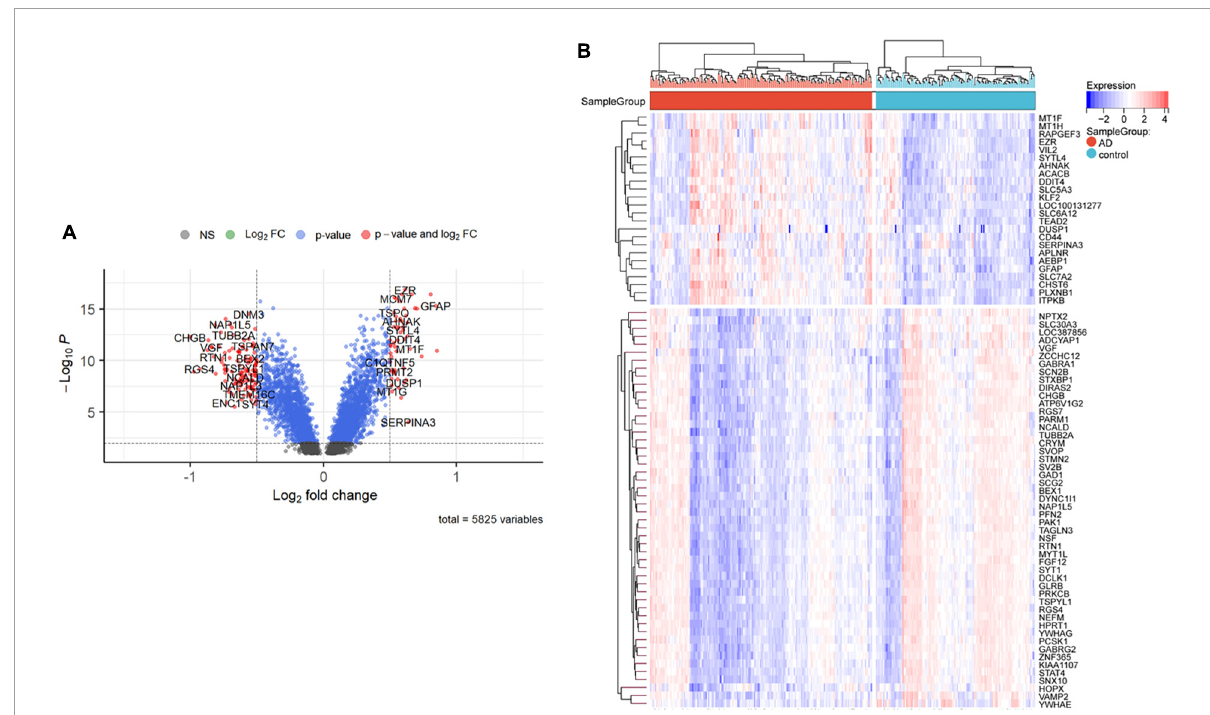
FIGURE1 Differentially expressed genes between AD and control samples. (A) The right red genes represent significantly high expression in AD; the left red genes represent significantly high expression in control. (B) The heatmap shows the top 50 genes significantly expressed in AD or ND